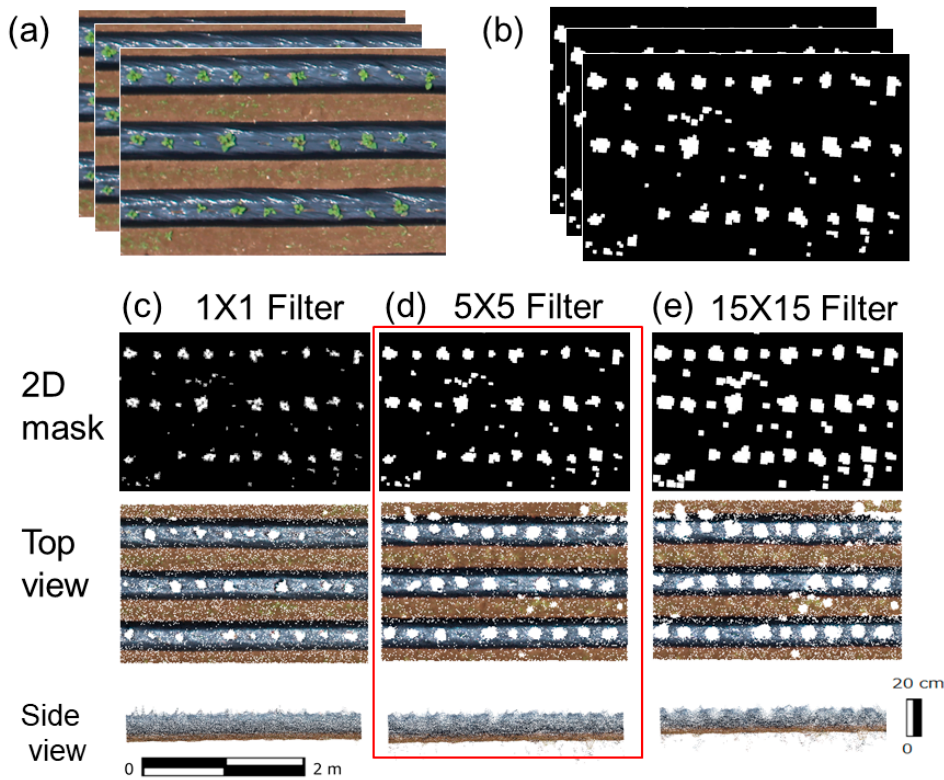
Figure 3. Examples of plant area removal and enlargement filtering. ( a ) 2D images; ( b ) Images after plant removal process; ( c ) 1 × 1 enlargement filtered data; ( d ) 5 × 5 enlargement filtered data; ( e ) 15 × 15 enlargement filtered data.